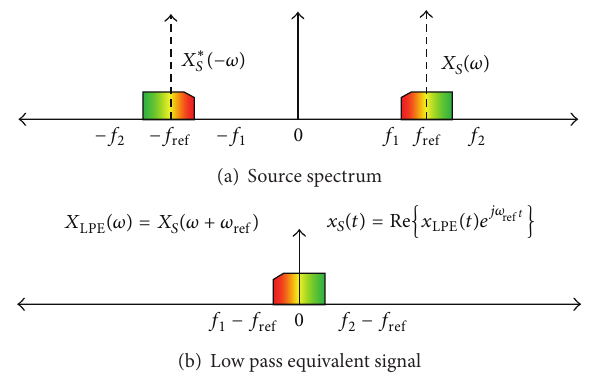
Figure 2: Low pass equivalent signal spectrum of the transmitting